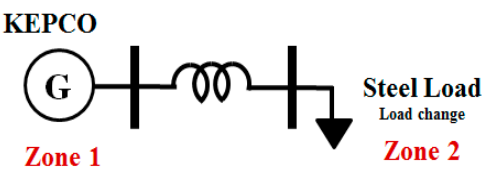
Figure 24. Simulation model.